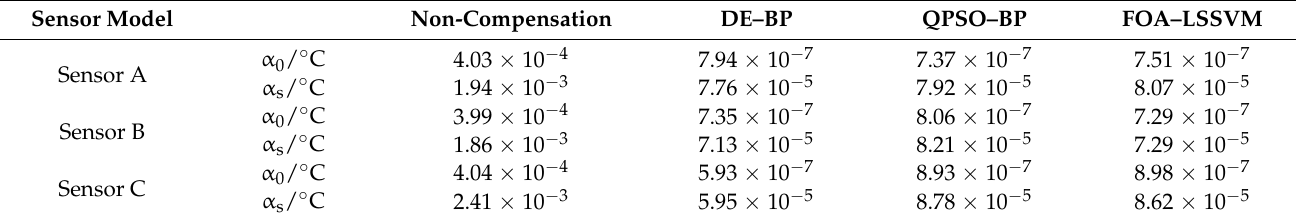
Table 6. Comparison of temperature compensation results based on different algorithms.